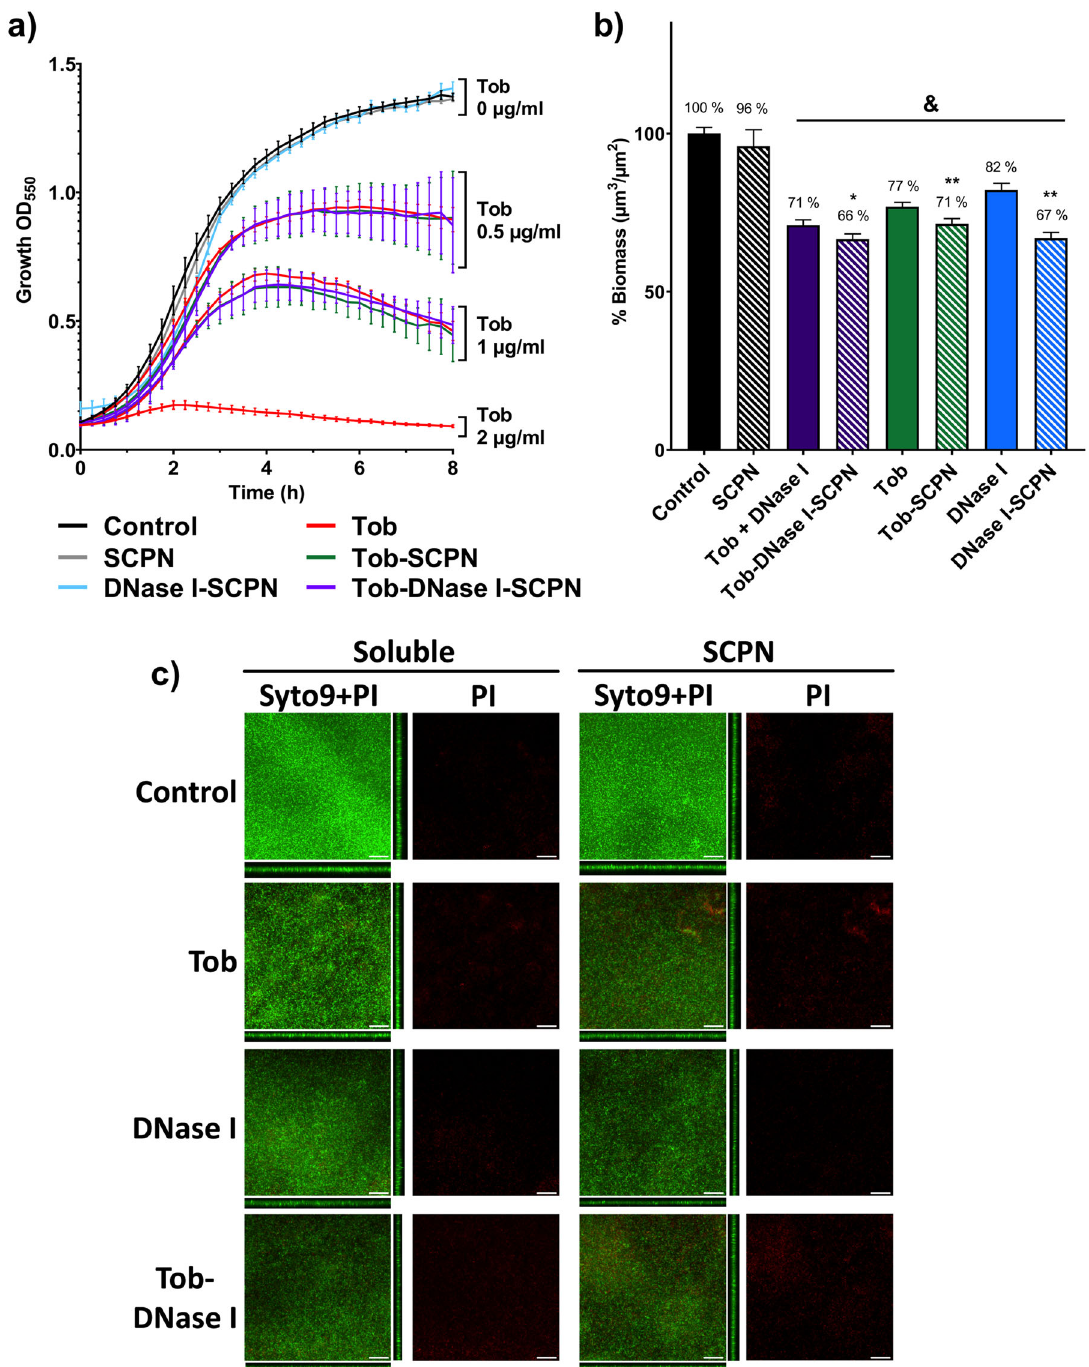
Fig. 2 P. aeruginosa planktonic and bio fi lm treatments with different SCPNs. a Eight-hour bacterial growth curves for P. aeruginosa treated with soluble tobramycin (Tob, red) and different nanoparticles containing 0 µg/ml Tob (gray, 50 µg/ml SCPN; blue, 50 µg/ml DNase I-SCPN), 0.5 µg/ml Tob (green, 1.25 µg/ml Tob-SCPN; purple, 2.2 µg/ml Tob-DNase I-SCPN) and 1 µg/ml Tob (green, 2.5 µg/ml Tob-SCPN; purple, 4.3 µg/ ml Tob-DNase I-SCPN). Black lines (control) represent growth without any treatment. Error bars indicate the standard deviation between three experiments with three replicates of each experiment. b Degradation of 72 h-old bio fi lms of P. aeruginosa treated for 16 h with 0.26 µg/ml DNase I and/or 2 µg/ml tobramycin (solid bars) and with nanoformulation containing SCPN with the corresponding concentration of both actives (striped bars). Blue, green and purple bars correspond to DNase I treatment, antibiotic tobramycin, and both treatments together, respectively. Data for the control (nontreated bio fi lm) and SCPN (without tobramycin and DNase I) are shown in black bars. All values are normalized against the control sample. Error bars indicate the standard deviation between two experiments with at least three replicates of each experiment. Statistical analyses were performed with the Student Unpaired t test ( & p < 0.005 vs. Control, * p < 0.05; ** p < 0.005 vs. treatment without SCPN) to determine signi fi cance. c Confocal laser scanning microscopy images of Live/Dead-stained P. aeruginosa bio fi lms. In each condition, it is shown the sum of the stack and the corresponding orthogonal views of merged live (Syto9) and dead (PI) staining and only the dead (PI) staining. The scale bar represents 40